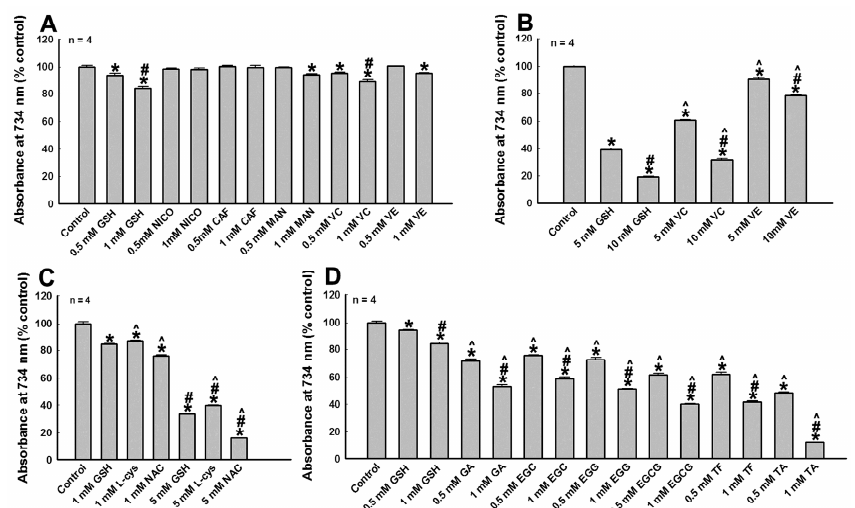
Figure 2. Detections of reductive potency of tea polyphenols and other agents. The reductive potencies of tea polyphenols and various Parkinson’s disease (PD)-related agents were detected by 2,2 ′ -azino-bis(3-ethylbenzothiazoline-6-sulfonic acid) diammonium salt (ABTS) cation decolorization assay. Solutions in the absence of polyphenols and other agents are set as controls. The reductive potency of various agents at di ff erent concentration is expressed as % control of absorbance at 734 nm in ABTS cation decolorization reactions. *, at least p < 0.05, compared with the absorbance at 734 nm of controls. #, at least p < 0.05, compared with the absorbance at 734 nm of the same agents at lower concentration. ˆ, at least p < 0.05, compared with the absorbance at 734 nm of GSH at the same concentration. ( A ) Analysis of reductive potency of GSH, NICO, CAF, MAN, VC and VE at 0.5 and 1 mM dosage. ( B ) Dosage dependent reductive potency of GSH, VC and VE. ( C ) Dosage dependent reductive potency of GSH, NAC and L-cys. ( D ) Analysis of reductive potency of GSH and tea polyphenols.